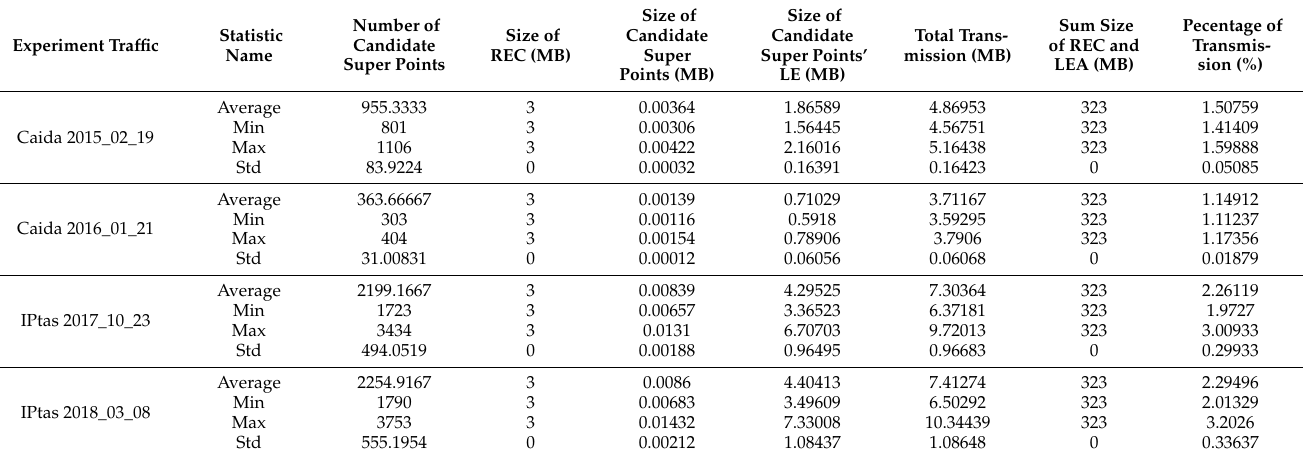
Table 4. Transmitting data between each observation node and the global